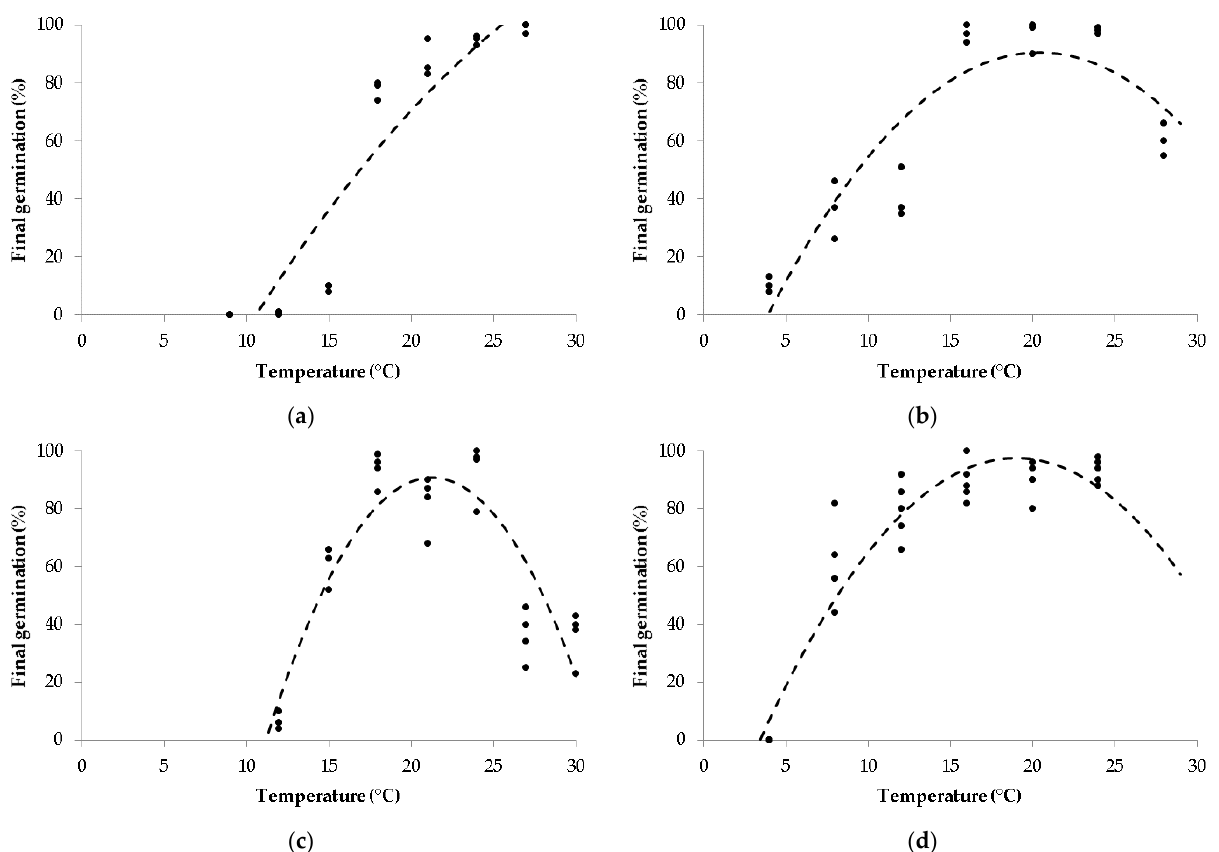
Figure 1. Final germination (%) of A. retroflexus, C. album , P. capillare , and S. pumila at studied temperatures. The dotted line represents the regression line and the points the observed final germination percentages. Estimated function are: ( a ) Amaranthus retroflexus y = −0.1x 2 + 11.8x − 108.6, r 2 = 0.87; ( b ) Chenopodium album y = −0.3x 2 + 13.6x − 48.0, r 2 = 0.82; ( c ) Panicum capillare y = −0.9x 2 + 38.1 − 314.1, r 2 = 0.78; ( d ) Setaria pumila y = −0.4x 2 + 15.3x − 47.9, r 2 = 0.91 .